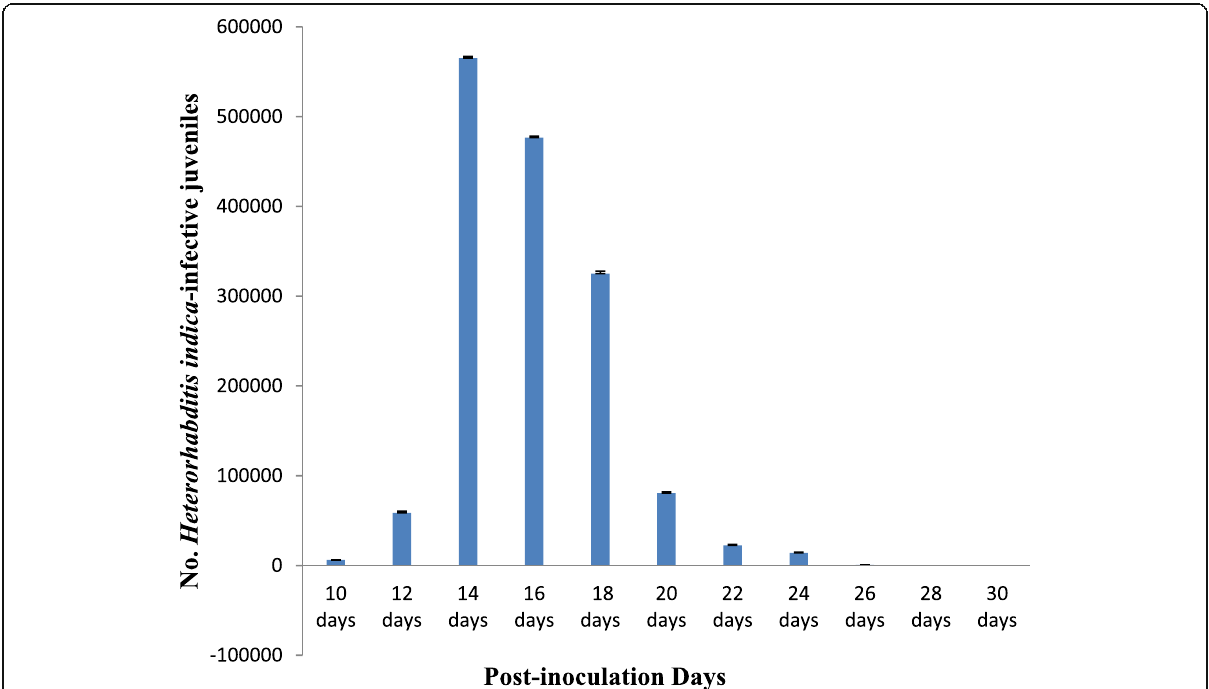
Fig. 1 Total numbers of nematode-infective juveniles for 38 nematode populations emerging from Temnorhynchus baal larvae at different days